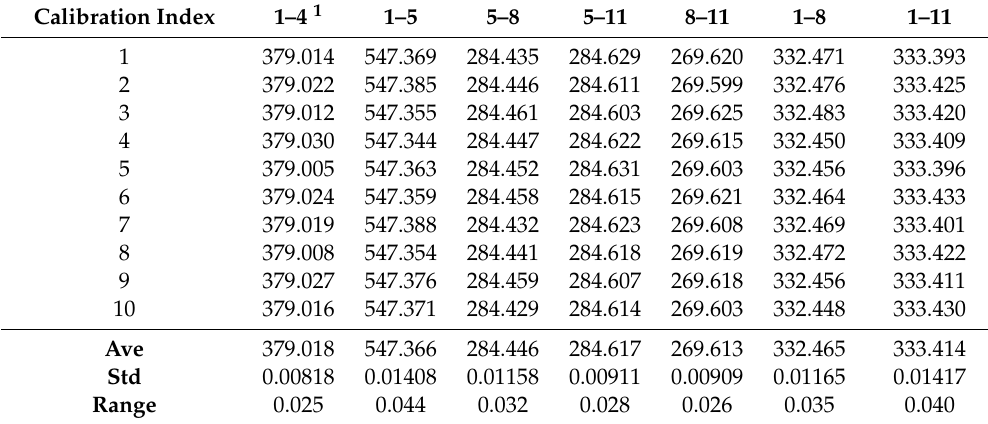
Table 4. Repeatability of nine representative distances between two control points. Ave is the abbreviation of average value. Std is the abbreviation of standard deviation.